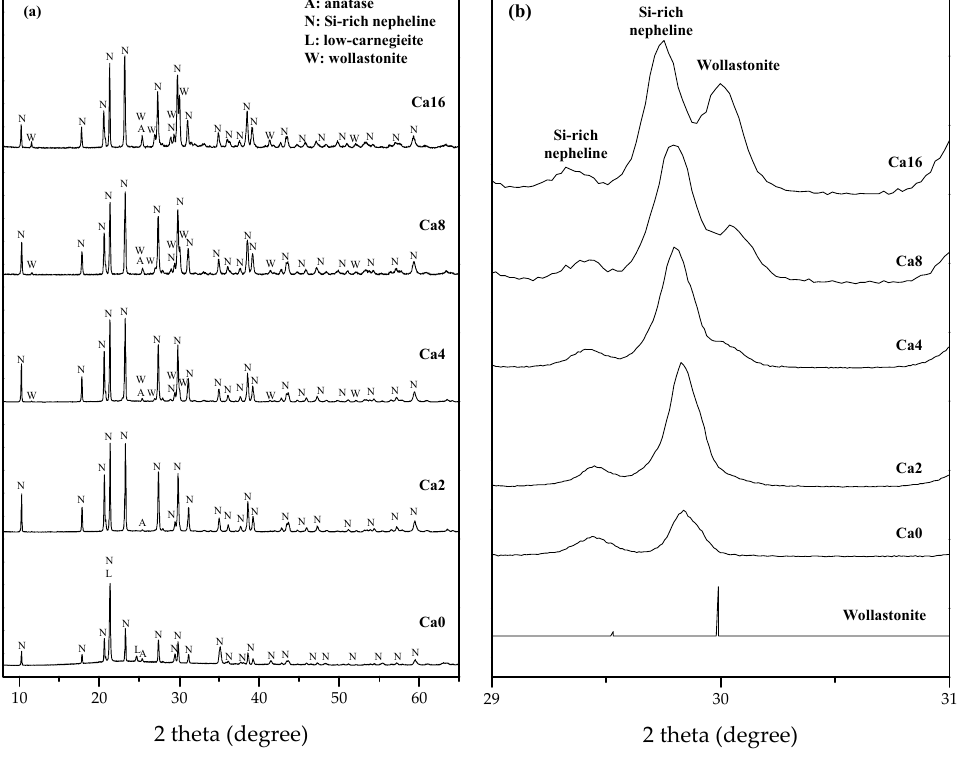
Figure 6. XRD analysis results of pure geopolymer and geopolymers containing calcium hydroxides post heat treatment ( a ) and 2 θ range from 29° to 31° ( b ); Si-rich nepheline and low-carnegieite were observed in Ca0 geopolymers as high temperature crystalline phases. The low reflection of wollastonite was confirmed in Ca4.